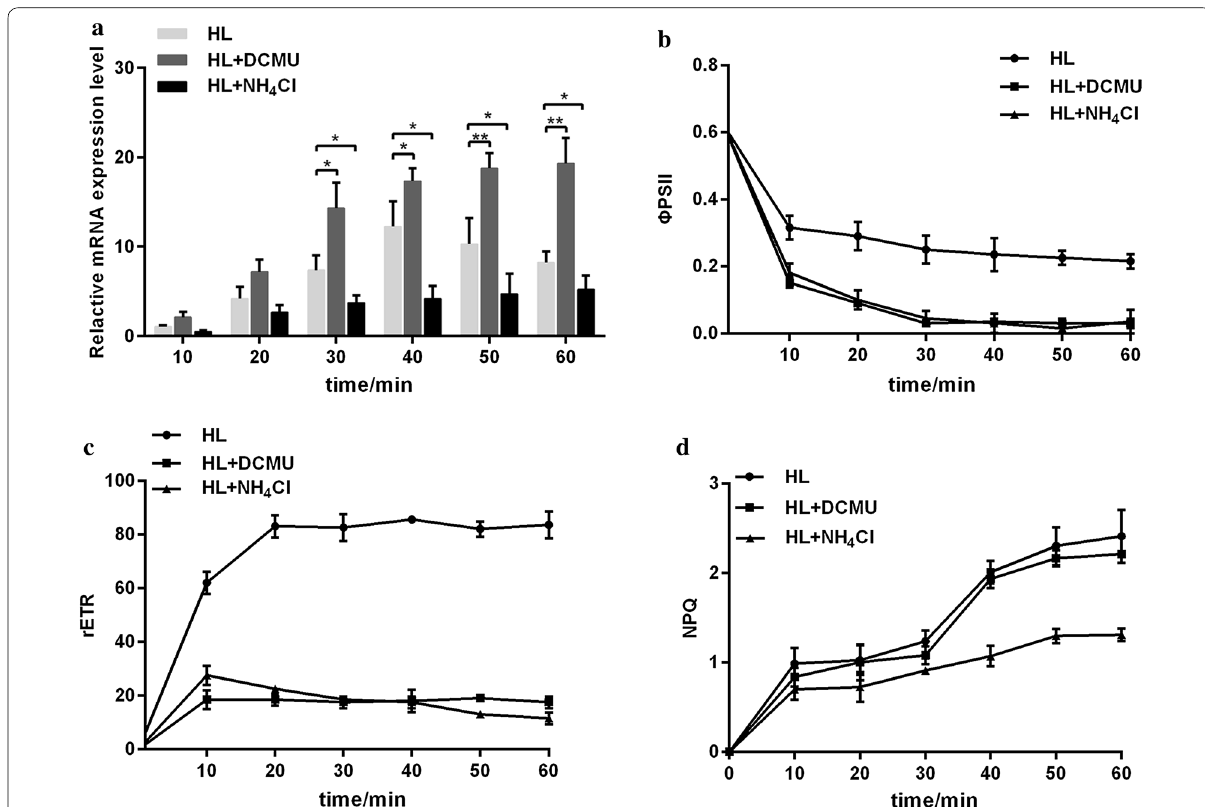
Fig. 3 Responses of Lhcx3 ( a ), Φ PSII ( b ), rETR ( c ) and NPQ ( d ) of P. tricornutum to inhibitor addition. HL represents the light intensity of 800 μmol m − 2 s − 1 . Significant difference is indicated at P < 0.05 (*) or P < 0.01 (**) level. Each value represents mean